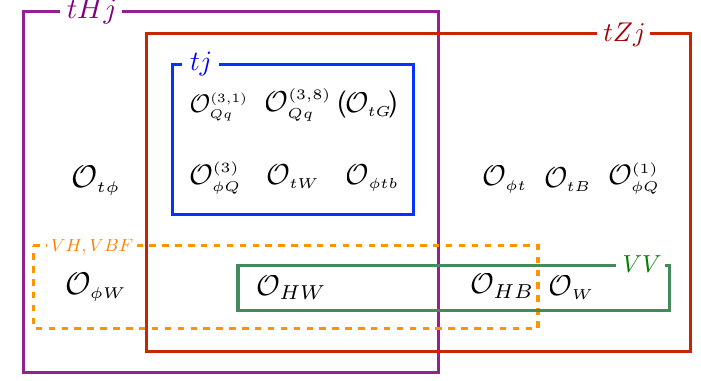
Figure 1 . Schematic representation of the interplay between operators and processes, focussing on single-top production and associated channels. Six ((cid:12)ve at LO and one at NLO in QCD) operators enter single-top production ( tj , blue square), and are therefore also present in Z boson ( tZj , red square) and in Higgs ( tHj , purple square) associated production. Operators exist that contribute to either tZj or tHj and also to both processes without contributing to tj . The operators entering in diboson ( V V ) production are a subset (green square) of those contributing to tZj , while some of the operators contributing to Higgs associated production ( V H ) and Vector Boson Fusion (VBF, orange dashed square) are shared between tHj and tZj